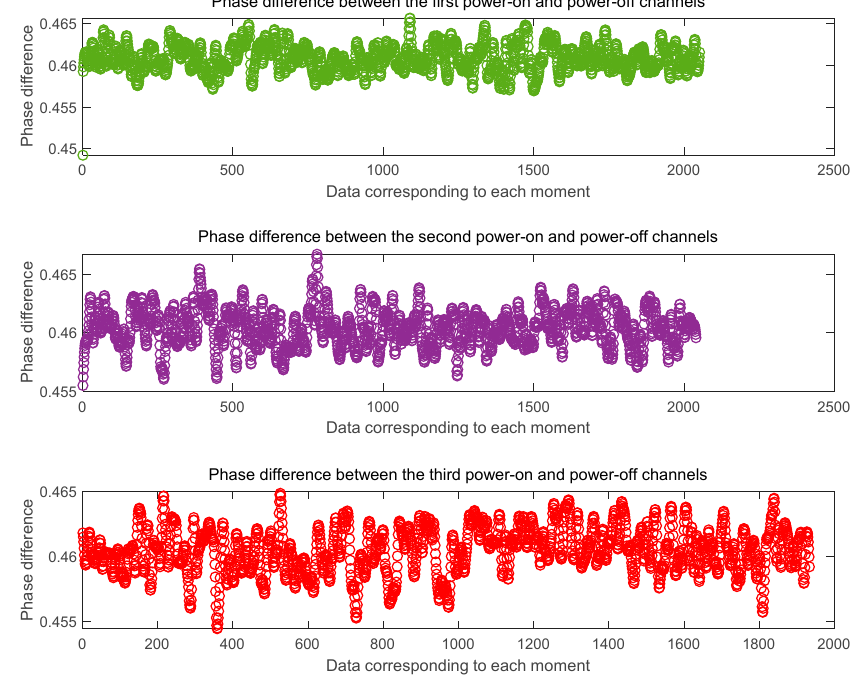
ff erence between B1 channels after three cold starts of the receiver. Sensors 2020 , 18 , x FOR PEER REVIEW